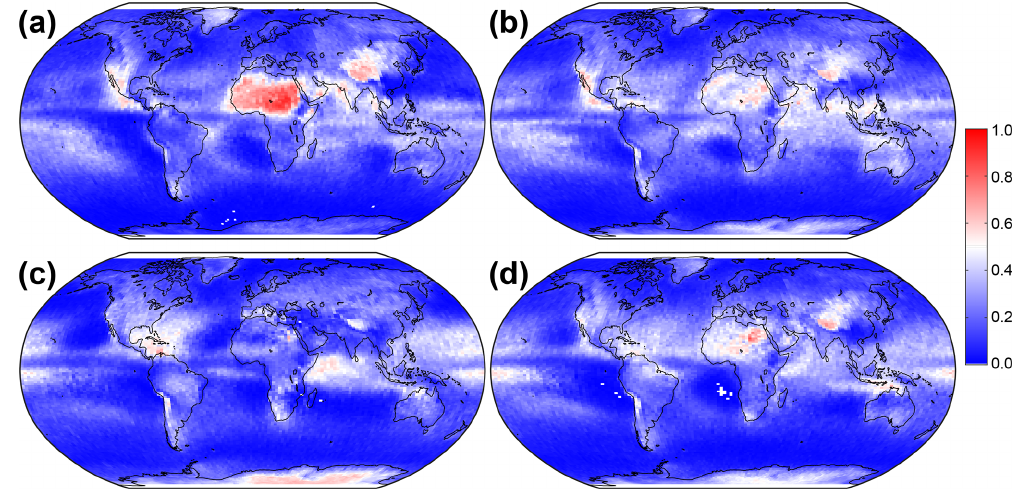
Figure 3. Same as Fig. 1a but for the 3-month periods (a) DJF, (b) MAM, (c) JJA, and (d)